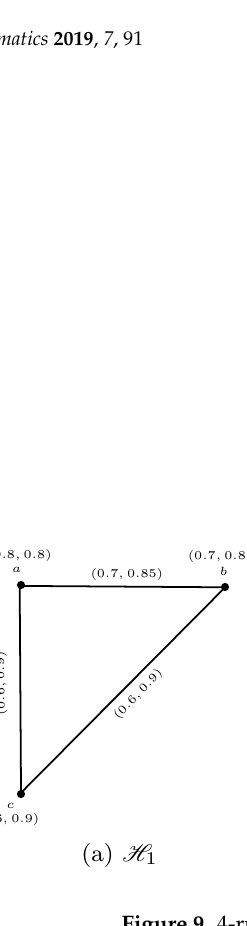
Figure 3.7: 4-rung orthopair fuzzy induced subgraphs Figure 9. 4-rung orthopair fuzzy induced subgraphs. ( a ) H 1 ; ( b ) H 2 ; ( c ) H 3